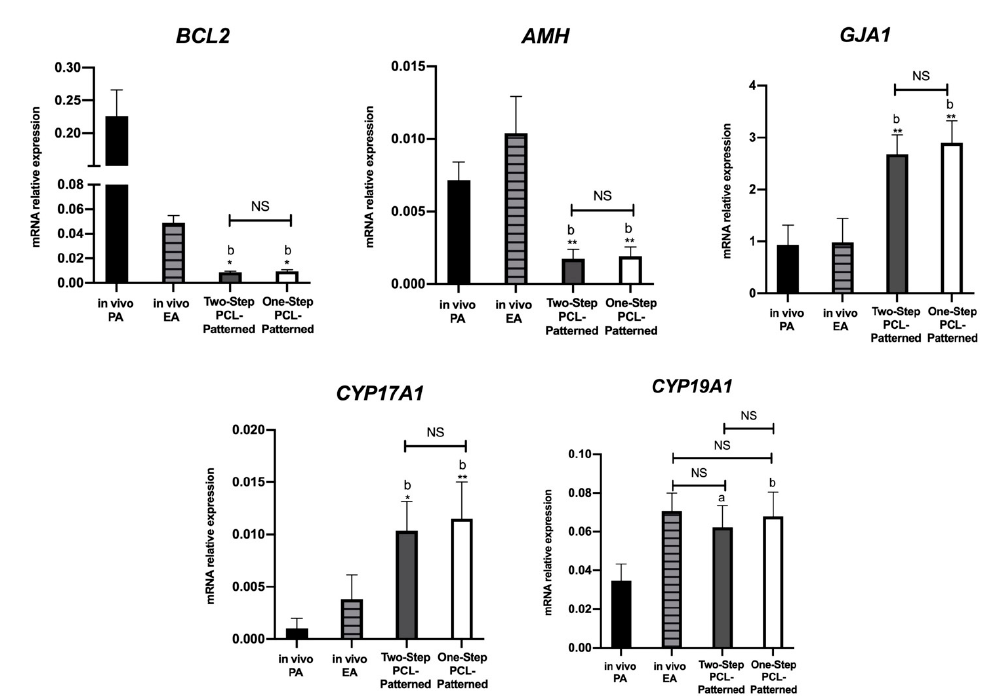
Figure 12. Representative expression of steroidogenic and somatic-specific genes. Twelve follicular walls per group were processed for gene expression analysis. Data were expressed as mean ± SD. a,b : statistically significant vs. in vivo PA follicles group ( p < 0.05 and p < 0.01, respectively). *, **: statistically significant vs. in vivo EA follicles group ( p < 0.05 and p < 0.01, respectively). NS: not statistically